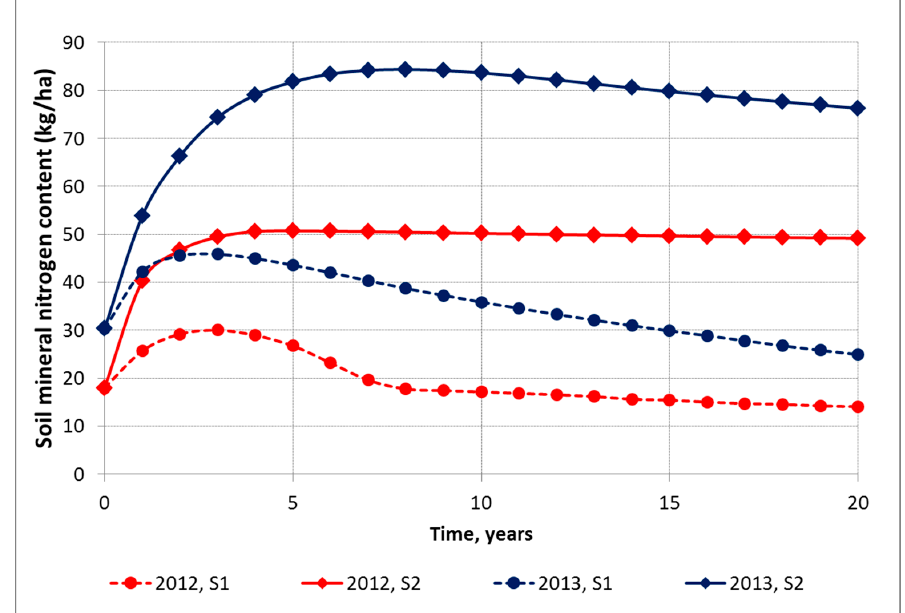
Figure 5. Long-term dynamics of mineral nitrogen content under different land use strategies for two benchmark weather realizations. Plant—spring wheat. Weather datasets—2012, 2013 vegetation periods in Men’kovo Experimental Station (Leningrad Region, Russia). S1—traditional technology—all above-ground biomass removed from the field, S2—“green manure” technology—all above-ground biomass remained on the field.